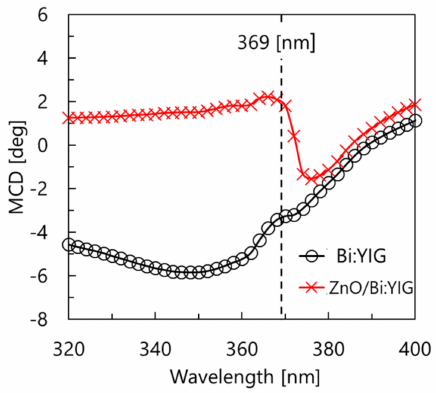
Figure 7. Magnetic circular dichroism (MCD) spectra of Bi:YIG and